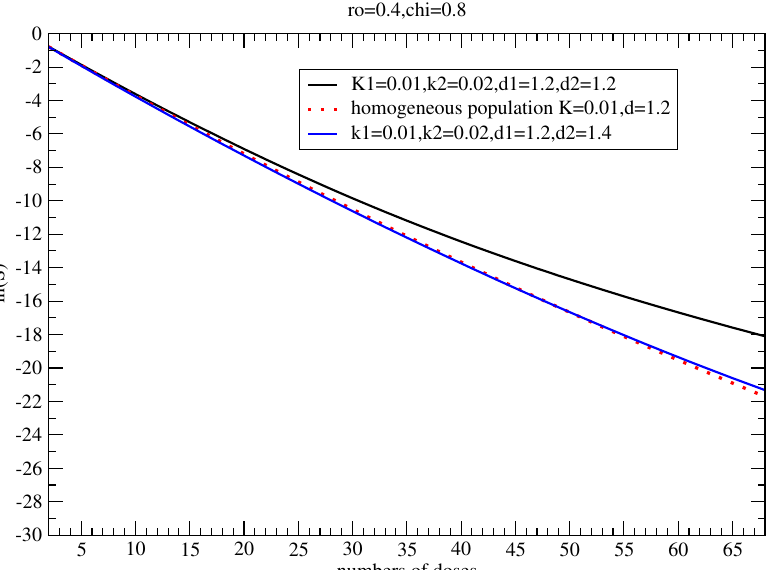
Figure 4. Estimate of the dose-boost with the same parameters of Figure 2 for a hyperfraction- ated schedule.